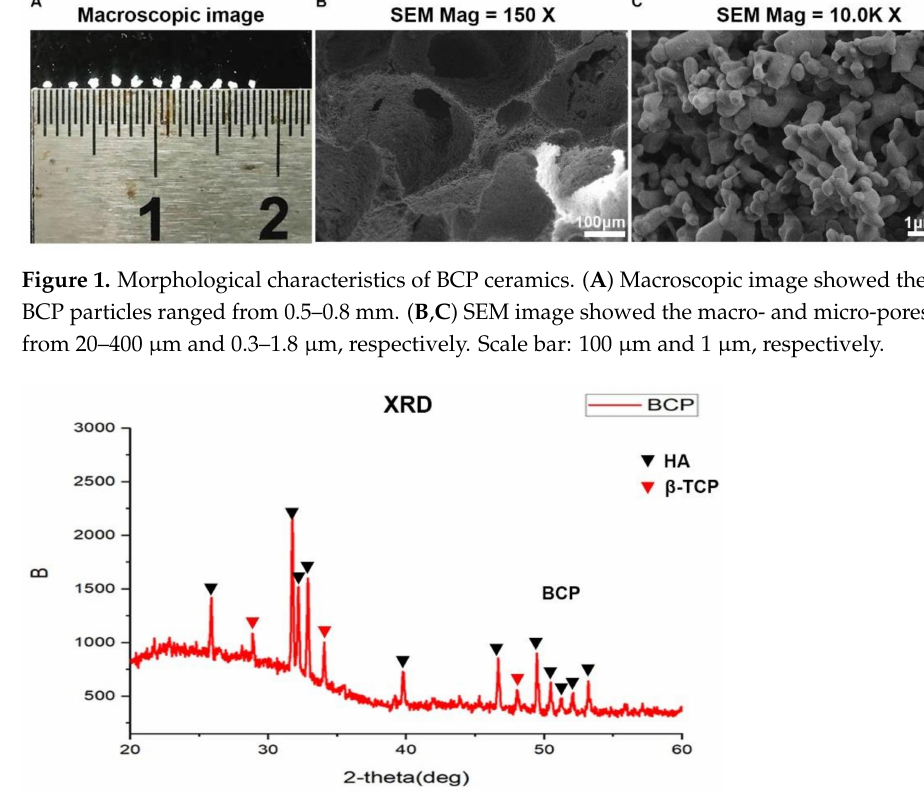
Figure 2. X-ray diffraction pattern of BCP ceramics. The pattern for BCP ceramics has several HA and β -TCP peaks.